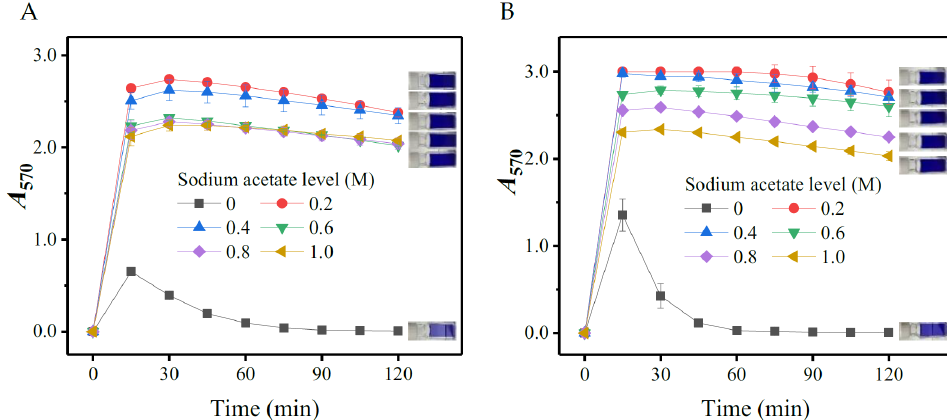
Figure 5. Effects of pH on the color yield of gamma-aminobutyric acid ( A ) and L-glutamic acid ( B ). The rightmost part of each diagram shows the reacted mixtures containing 35 μ L of 0.8 M acetate buffer with different pHs (from top to bottom: 4.0, 4.5, 5.0, 5.4, 5.8, 6.2, and 7.0). A 570 : absorbance at 570 nm.